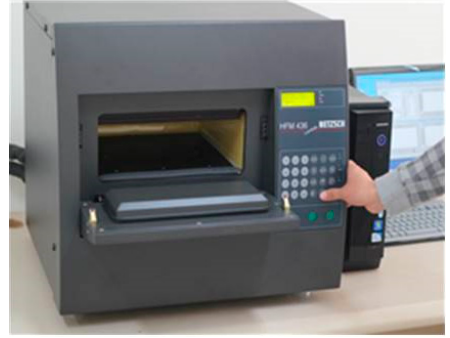
Figure 11. Thermal conductivity equipment. Table 6. Thermal conductivity